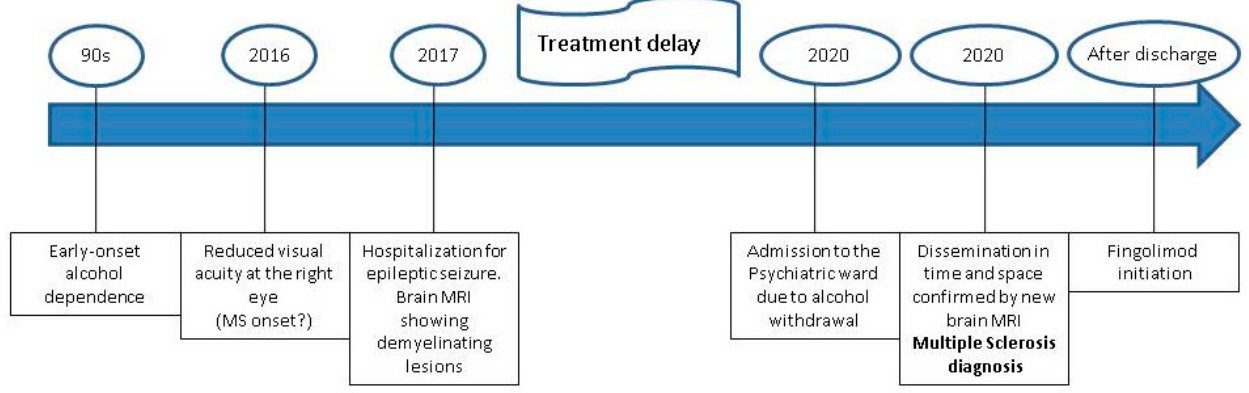
Figure 2. Timeline. The Figure shows the chronological summary of the most salient events in the medical history of the patient. Please note the significant diagnostic delay from the first MRI to the actual diagnosis of multiple sclerosis.